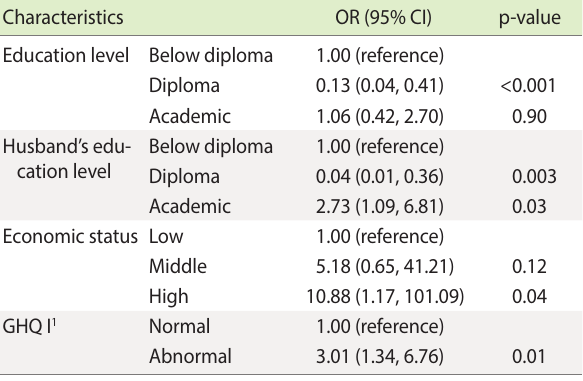
Table 4. The results of logistic regression model for delayed com- munication